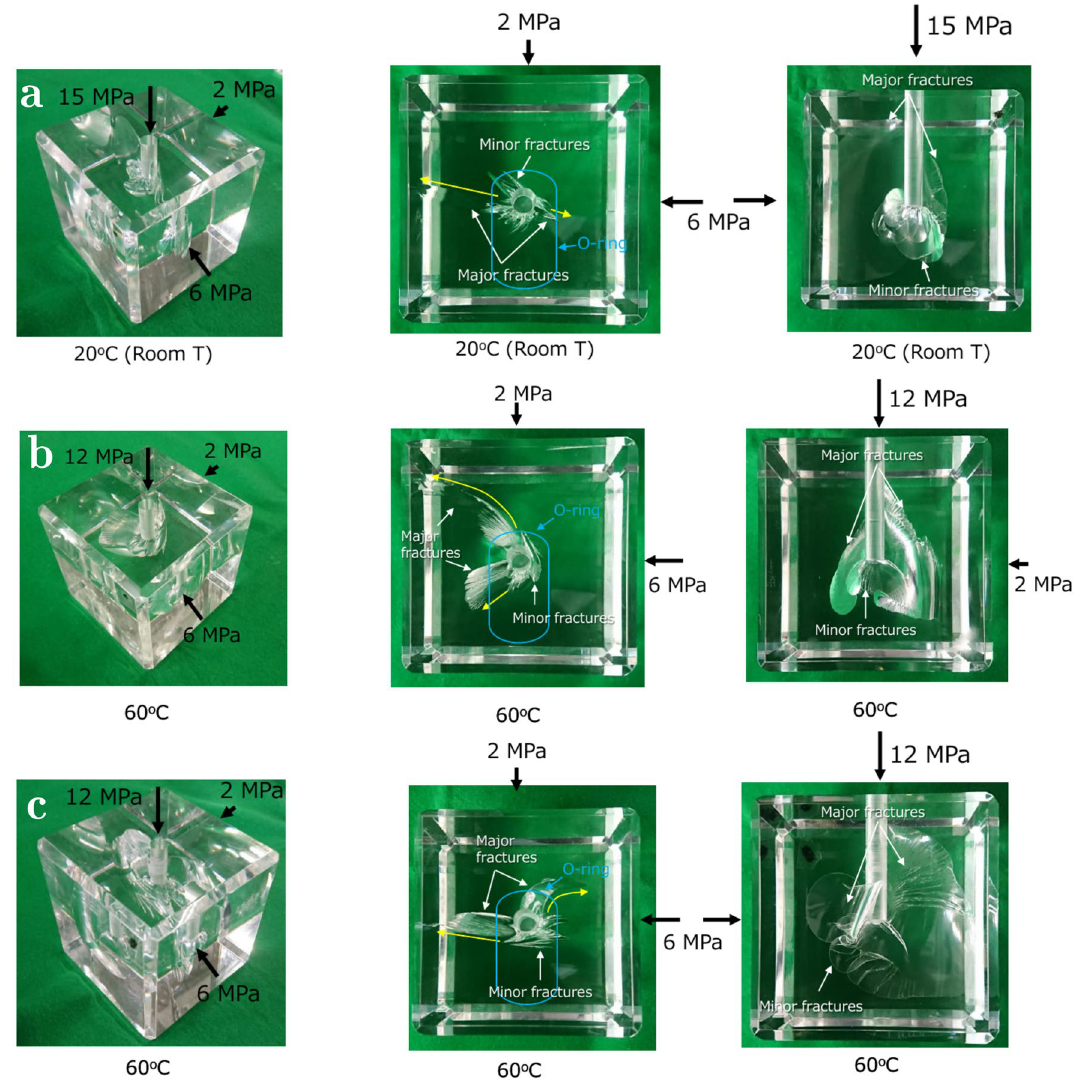
Figure 2. Images of the post-mortem samples tested following procedure P1 (see Methods) at 20 ◦ C ( a ) and twice at 60 ◦ C ( b and c ) for repeatability. The ensemble of mode-I and mixed-mode cracks creates a complex fracture topology, itself a result of stress concentrations around the well